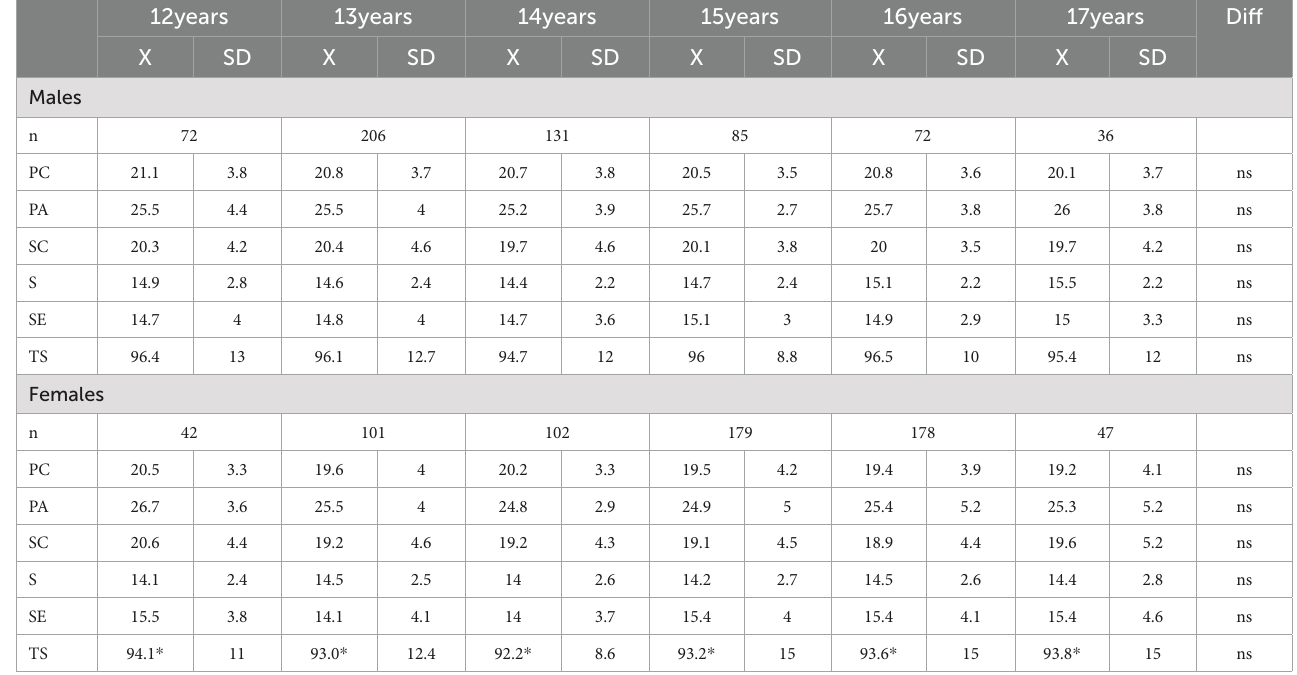
TABLE 2 Descriptive values (X ± SD) of the dimensions of the Physical self-concept scale by age and sex of the sample